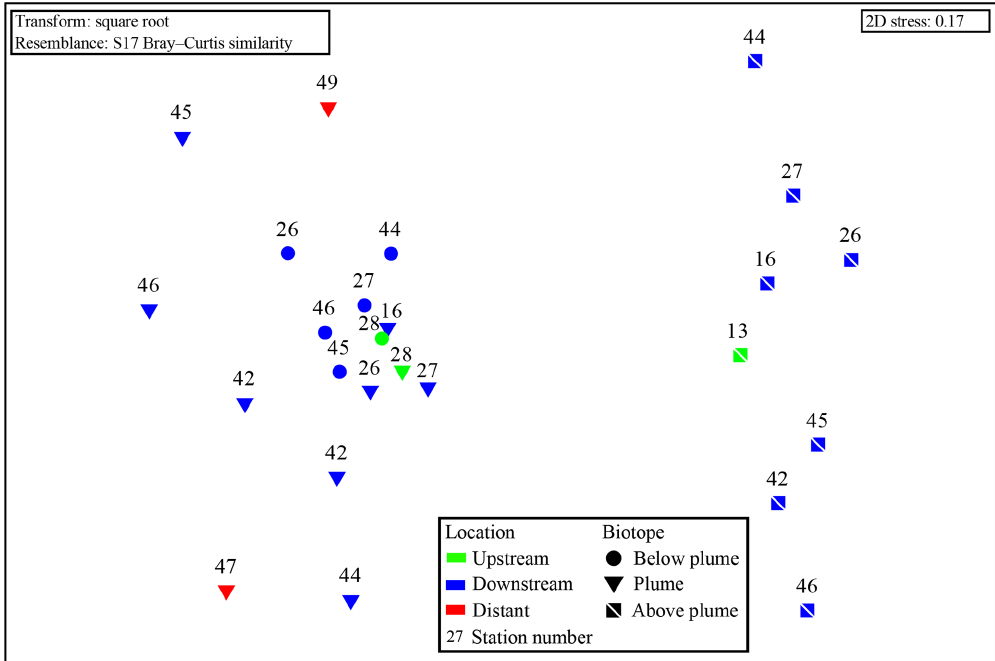
Figure 9. Non-metric multidimensional scaling plot of the microbial community composition of all water column samples based on Opera- tional Taxonomic units. Plume and below-plume depths from Station 13 were excluded.